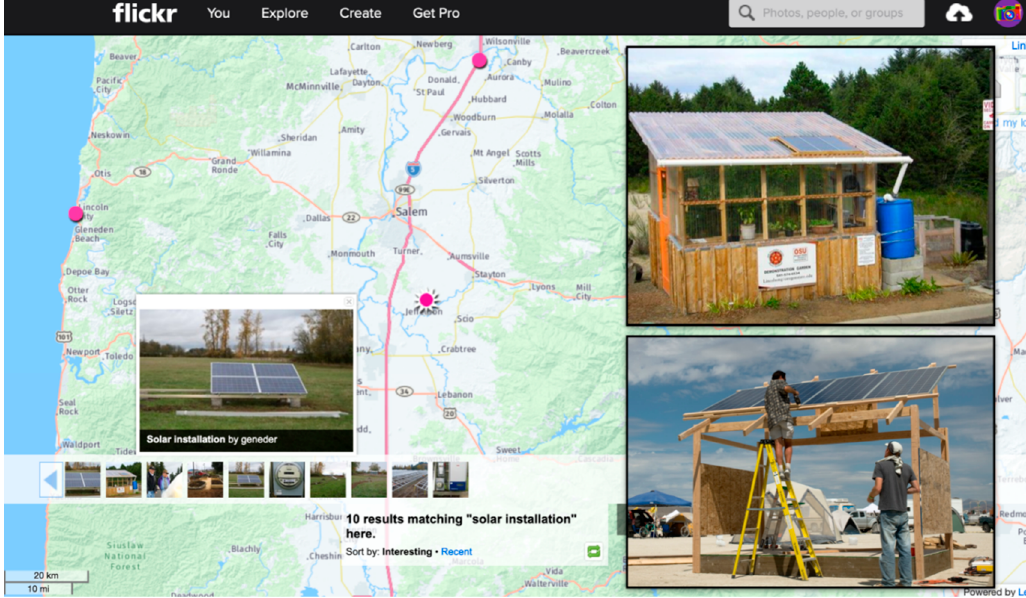
Figure 4. Example of solar power installations in geotagged images from Flickr.